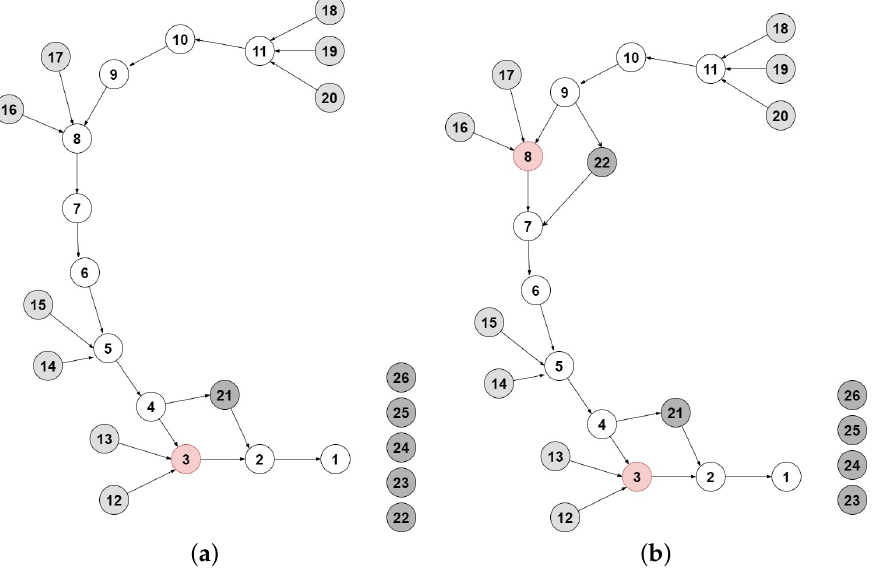
Figure 6. Scenario with no reuse. ( a ) First Congestion, ( b ) Second Congestion. Scenario 2: Node